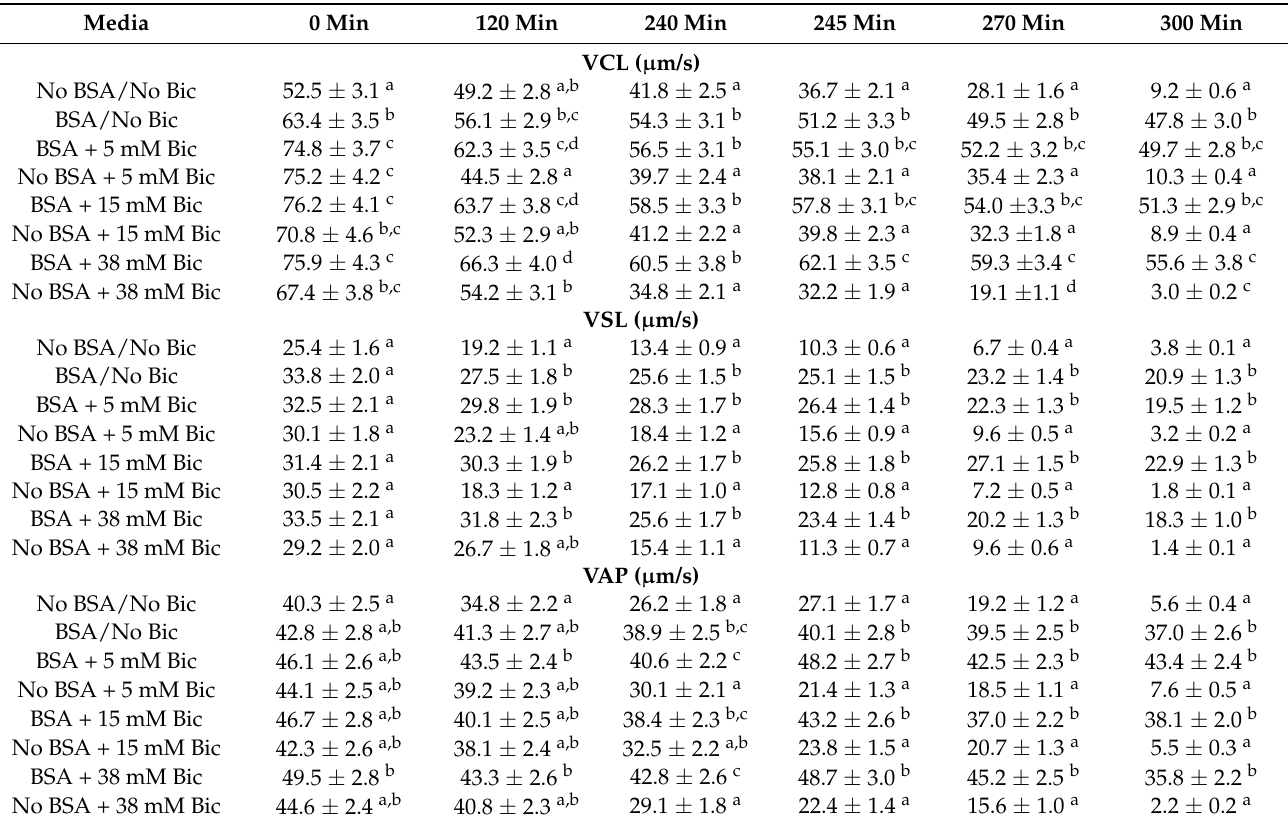
Table 1. Curvilinear velocity (VCL), straight-line velocity (VSL) and average path velocity (VAP) of pig sperm following incubation with different concentrations of bicarbonate (Bic; 0 mM, 5 mM, 15 mM, 38 mM) and BSA (0, 5 mg/mL) for 300 min. Progesterone (10 µ g/mL) was added at 240 min to induce acrosome exocytosis. Different superscripts (a–d) indicate significant differences ( p < 0.05) between treatments (rows) within the same time point. Data are shown as mean ± SEM for 12 independent